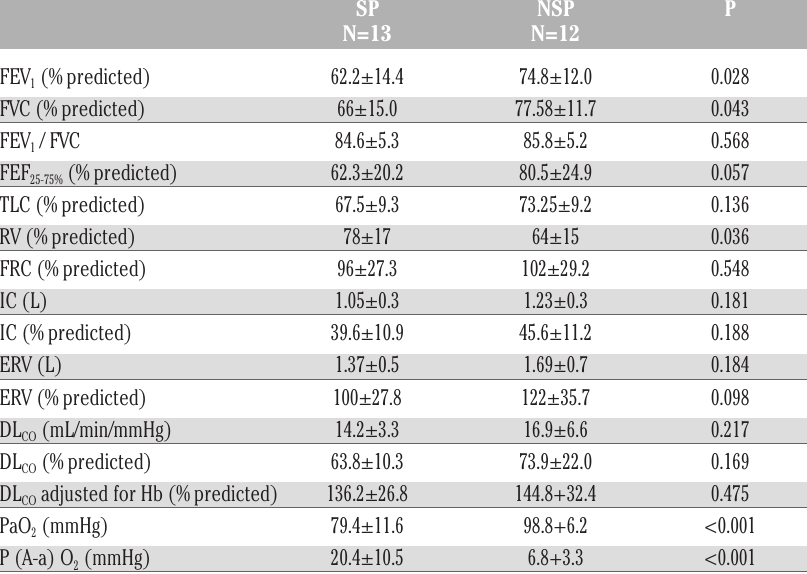
Table 2. Pulmonary functions and PaO , serum ferritin level between splenectomized and 2 non-splenectomized E/ β -thalassemia patients (data are expressed as mean ±